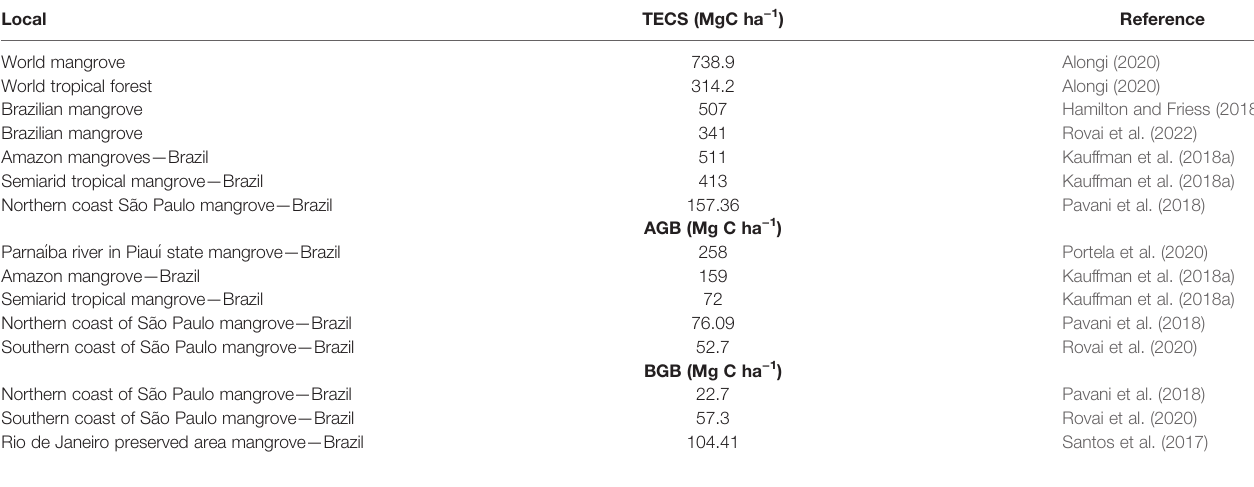
TABLE 2 | Carbon stock in different compartments (TECS, AGB, and BGB) of mangrove and tropical forest ecosystem. Local